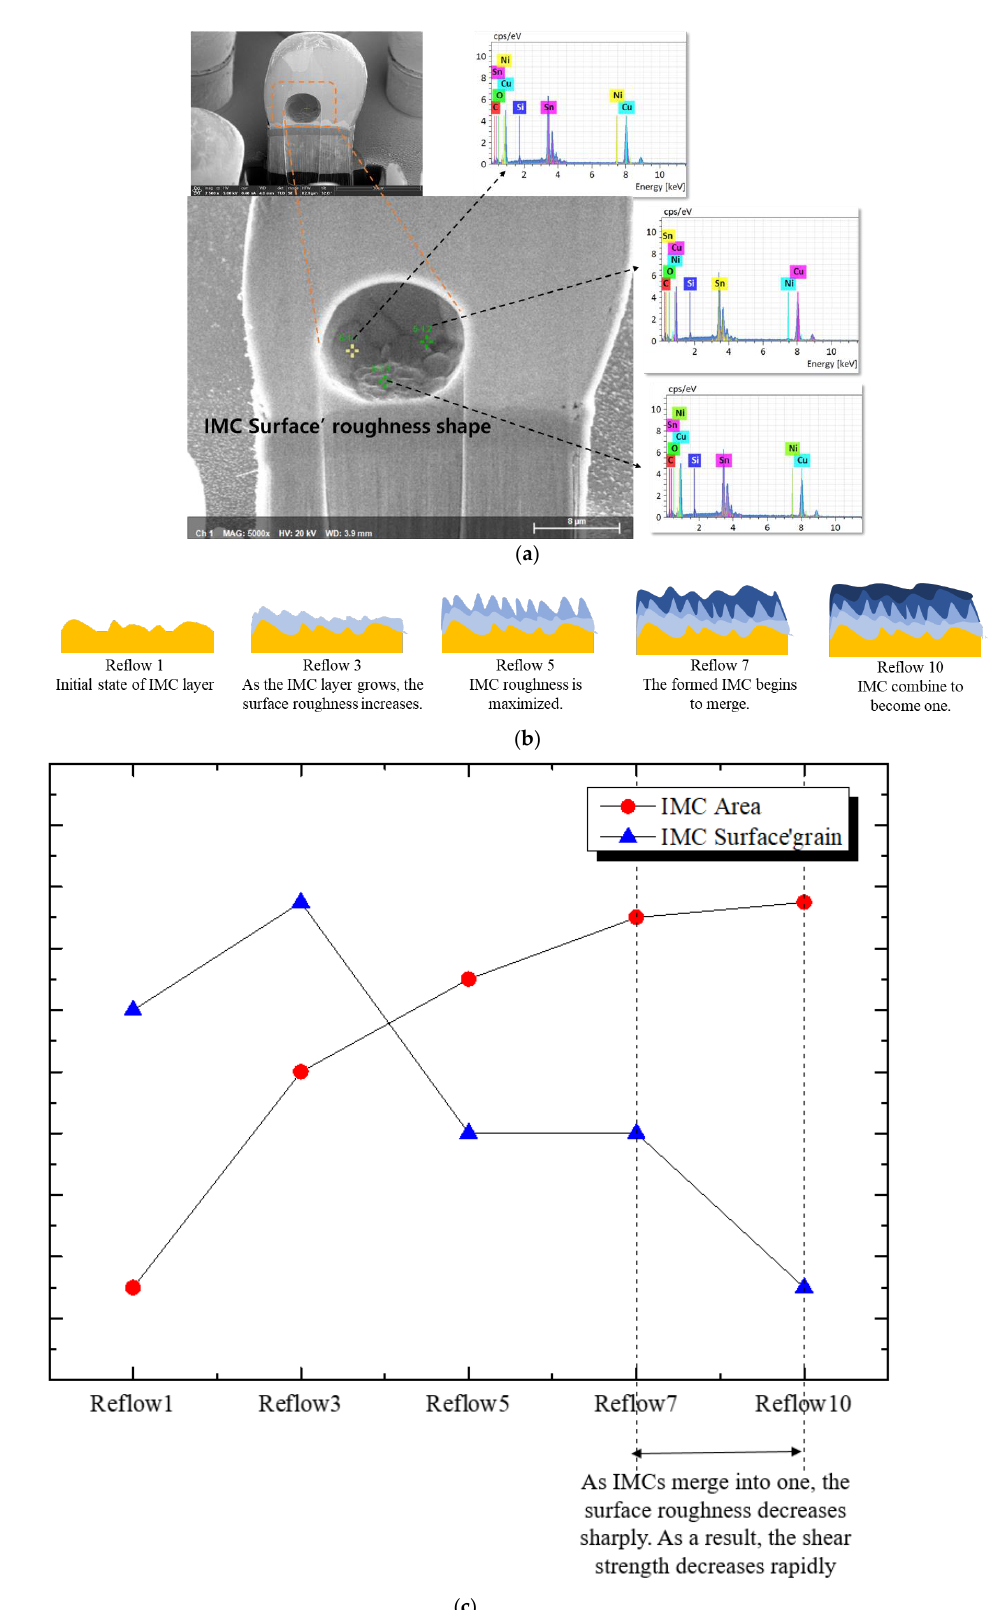
Figure 11. Correlation between IMC Formation Mechanism and Shear Strength. ( a ) IMC inner Section Shape, ( b ) IMC formation process, ( c ) Correlation between roughness and area. (b) Growth of IMC (Inter-Metallic Compound)